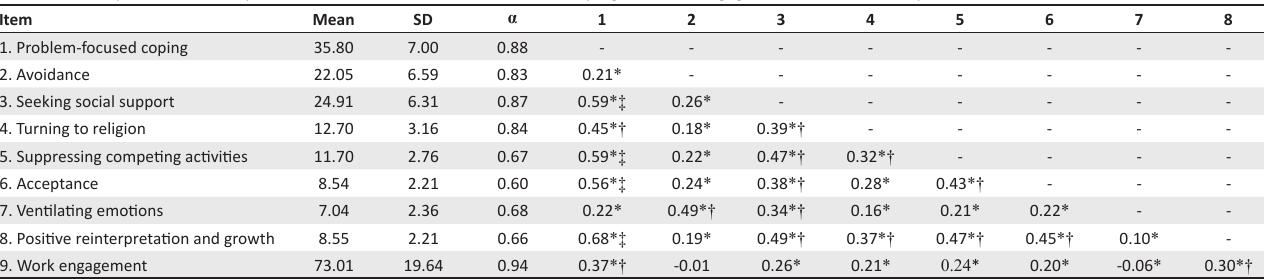
TABLE 4: Descriptive statistics, alpha coefficients and correlations between coping and work engagement in the total sample.